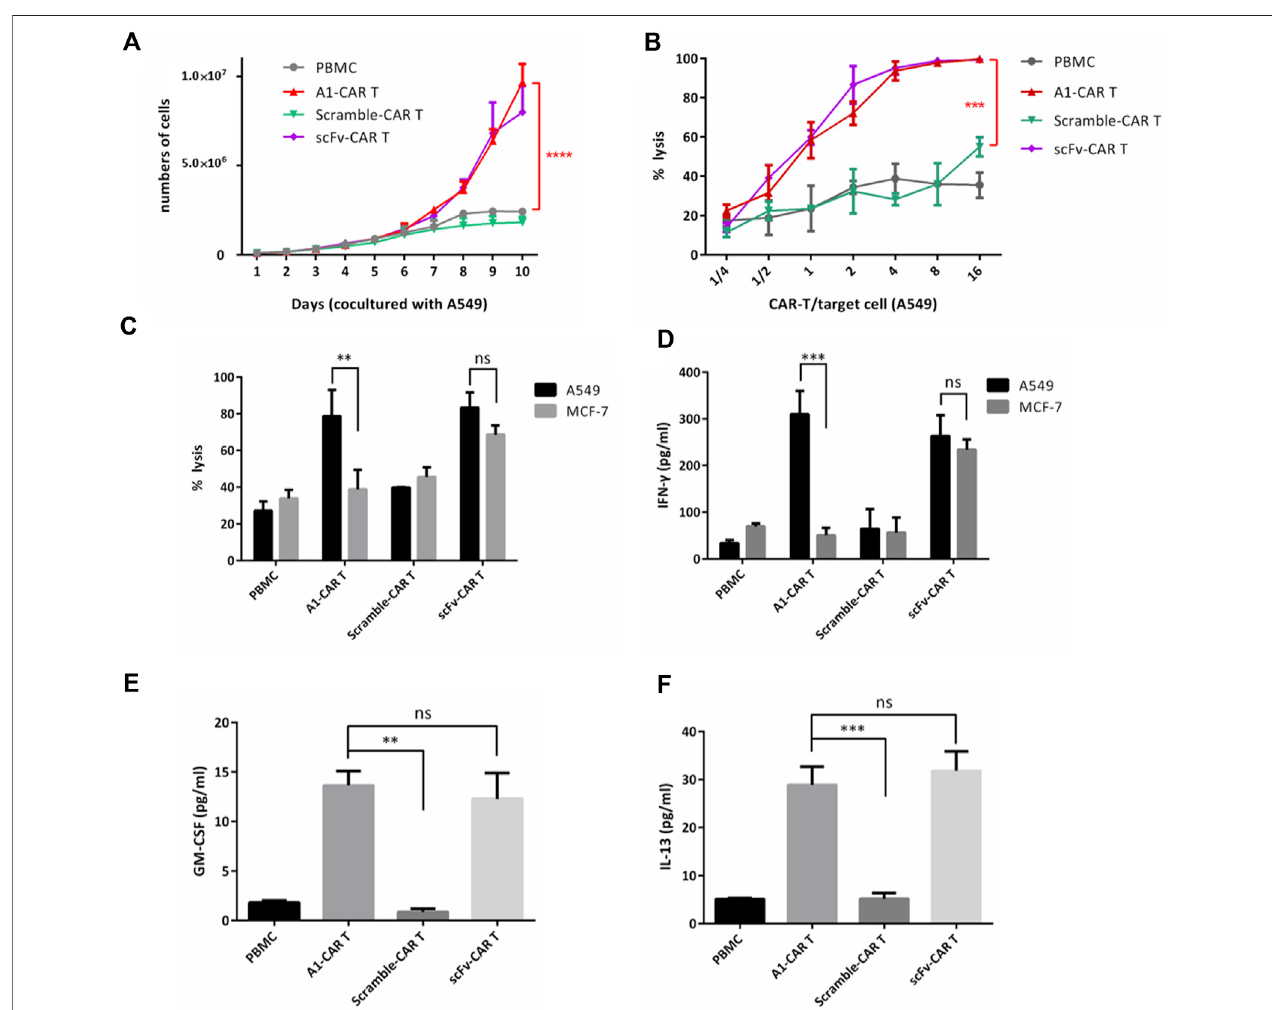
FIGURE 2 | Peptide based CARs could be effectively activated and showed killing effect on A549 tumor cells in vitro . (A) On different days 1:1 cocultured with mitomycin-C-treatedA549cells,thenumbersofPBMC,A1-CARs, scFv-CARs,andScramble-CARswereexamined(n=3).Ttestswereutilizedtodecidethe p values. (B) Cytotoxicity assay using A549-luc cells as targets. Data represent the mean ± SD of quadruplicate wells. T tests were utilized to decide the p values. (C) CARs were blended with target cells (A549-luc) at the effector/target (E/T = 4:1) ratios. 24 h later, Cytation three was used to detect bioluminescence to evaluate the percentageoflysis.CARsgeneratedfromsixindividualhumandonors.Ttestswereutilizedtodecidethe p values. (D – F) CARswereblendedwithtargetcells(A549-luc) at the effector/target (E/T= 4:1) ratios.Supernatantswereobtained 24 hafter coculture. Theamount ofIFN- γ , GM-CSF and IL-13wasanalyzed by fl uorescence-based ELISA Kit ( n = 4). Data represent the mean ± SD. T tests were utilized to decide the p